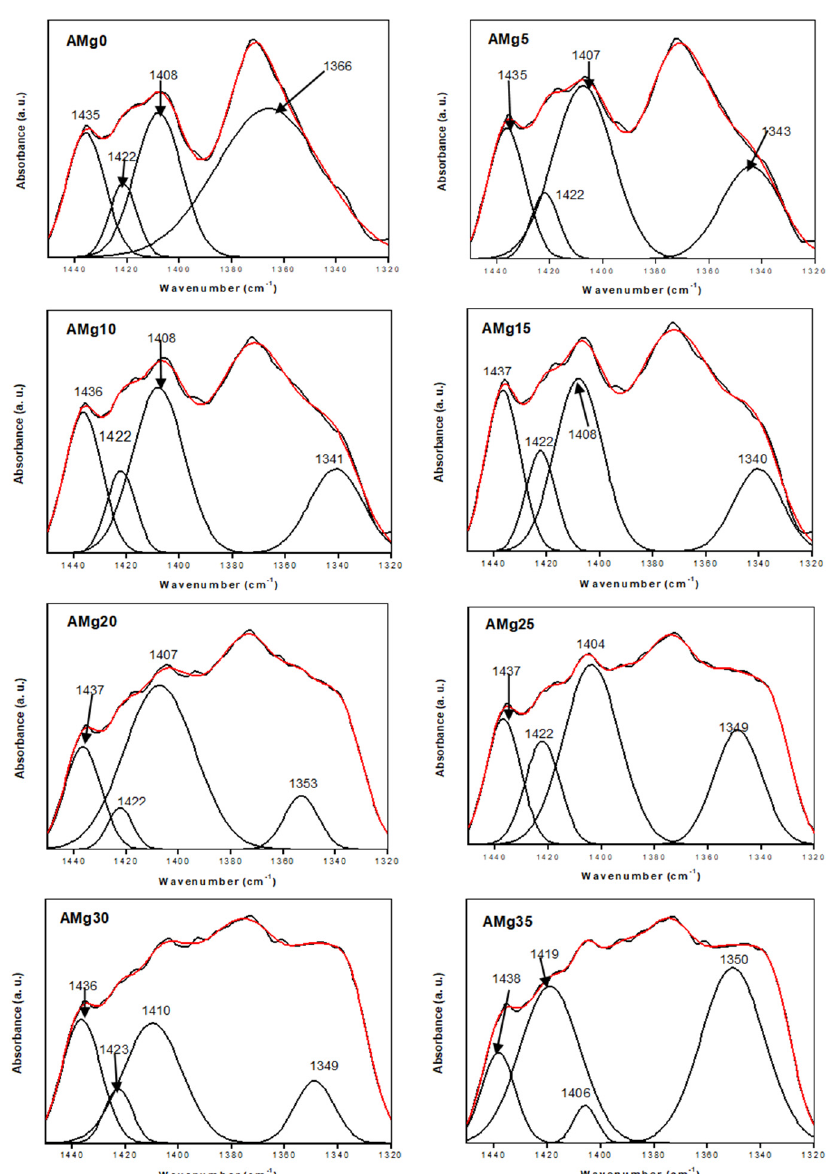
Figure 5. The deconvolution peak of FTIR spectra at a various weight percentage of Mg(NO 3 ) 2 doped in agarose–based gel polymer electrolyte at wavenumber range 1320 cm − 1 to 1450 cm − 1 .